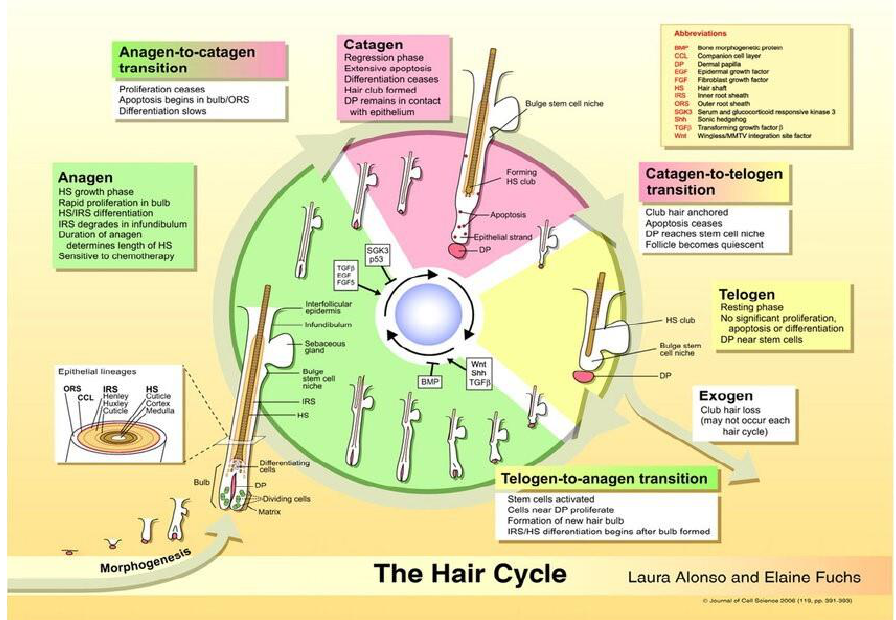
Figure 2. The Hair cycle “Reprinted with permission from Ref. [The hair cycle. Journal of cell science]. 2022, Alonso L, Fuchs E. et al.”